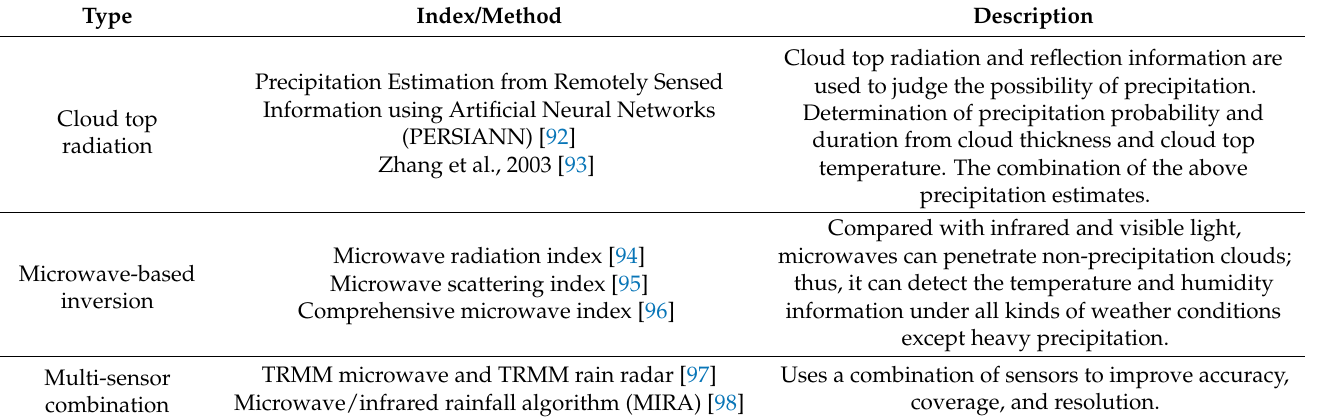
Table 4. Information extraction for